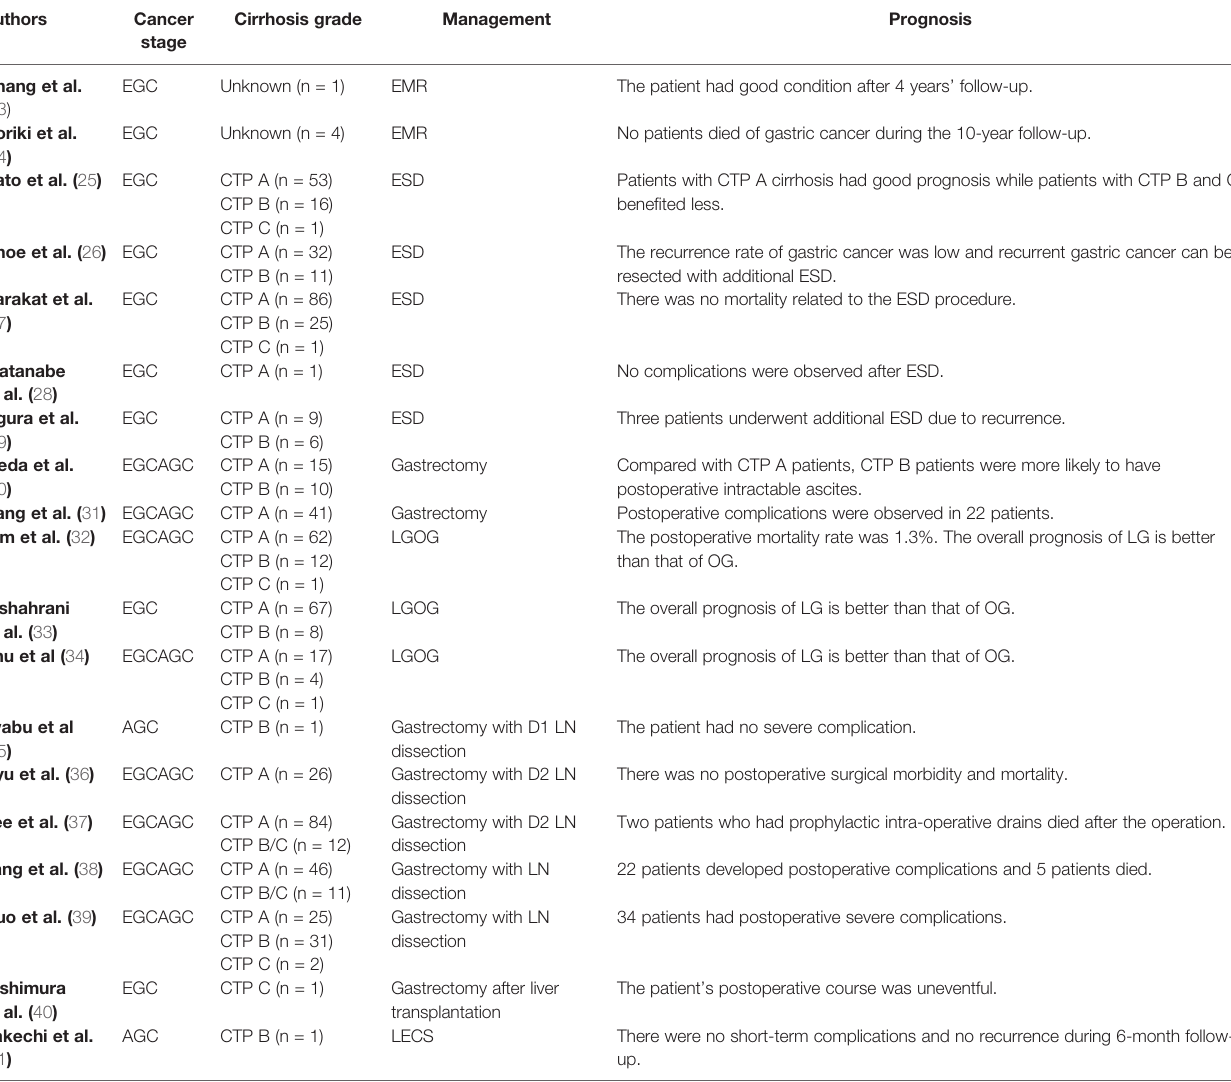
TABLE 1 | Summary of gastric cancer stage, cirrhosis grade, surgical choice and